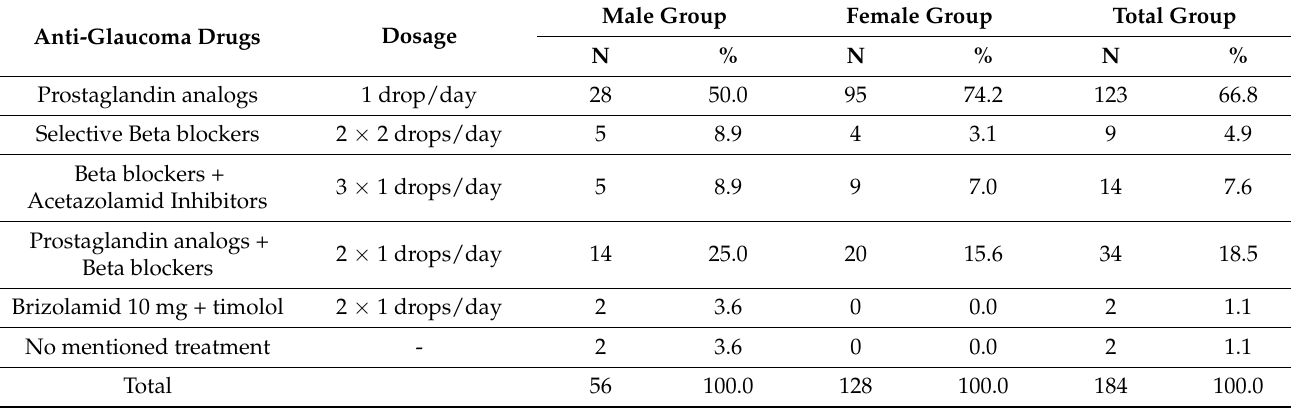
Table 14. Distribution of recommended drug classes and their dosage in the treatment of patients with POAG. Anti-Glaucoma Drugs